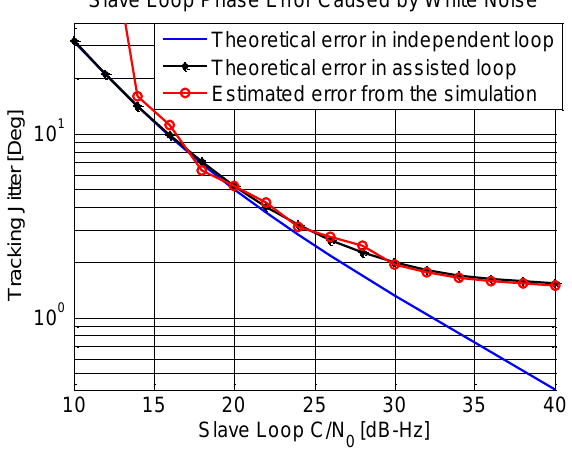
Figure 11. Phase jitter of slave loop output induced by thermal noise.